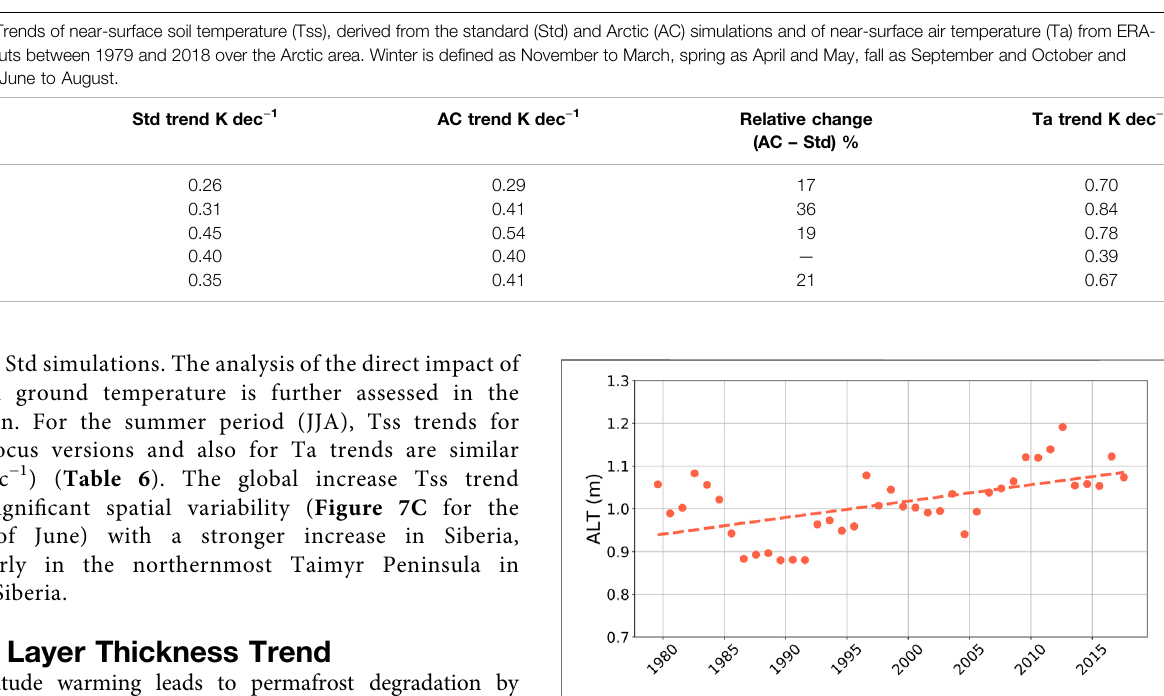
FIGURE 9 | Mean Arctic active layer thickness (ALT) evolution between 1979 and 2018 over the permafrost circumpolar area. The dotted line is the regression line (statistically signi fi